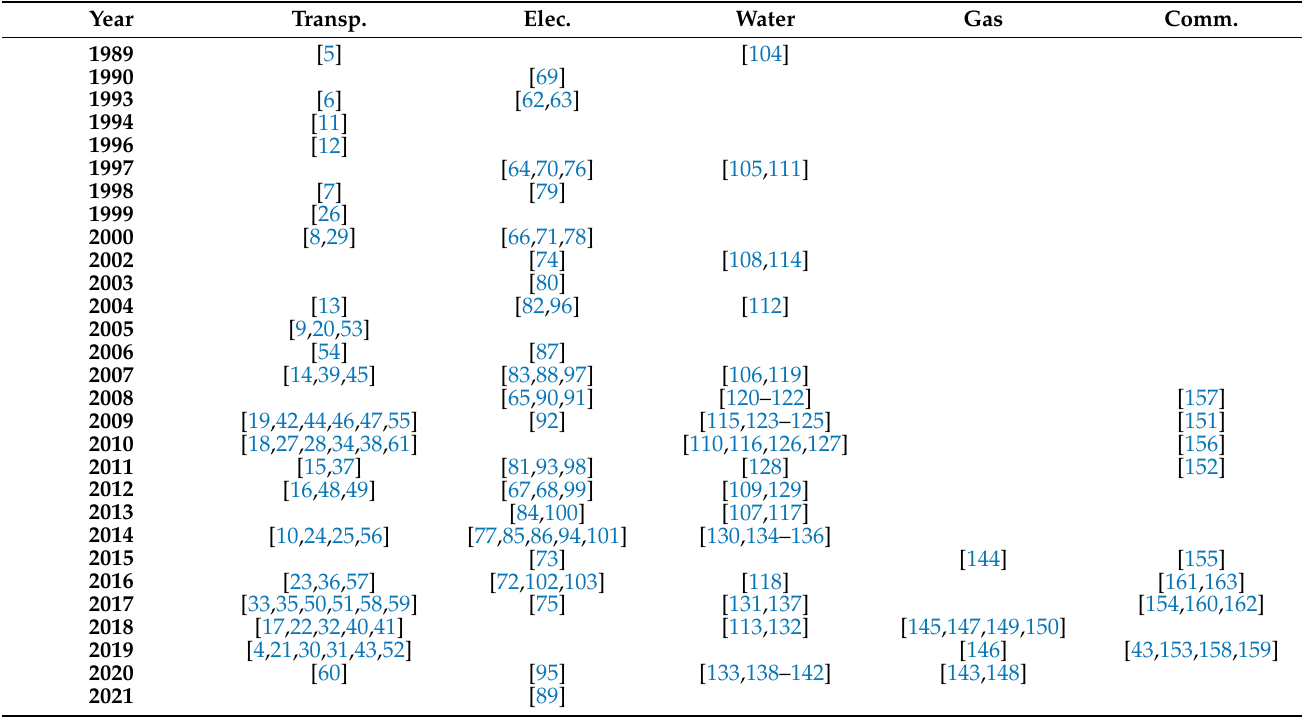
Table 1. Publications sorted with respect to subject and publishing year. Year